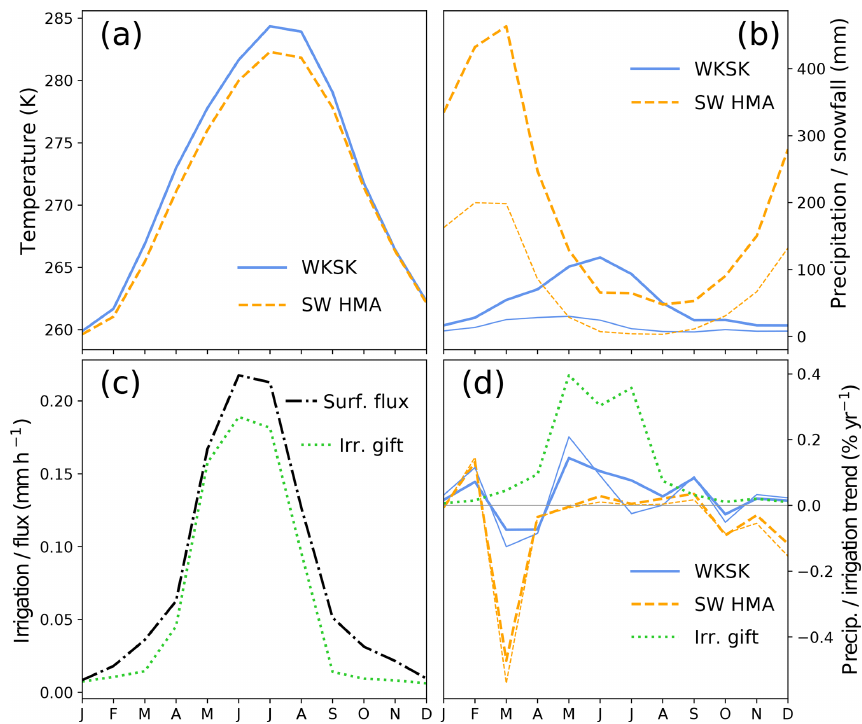
Figure 10. (a) Mean seasonal cycle of temperature and (b) precipitation (thick lines) and snowfall (thin lines) between 1980 and 2010 for the WKSK (blue lines) and south-western HMA (dashed orange lines), as shown in Fig. 14b, d. (c) Mean seasonal cycle of the irrigation gift (dotted green line) and surface moisture flux (dot-dashed black line) of the most heavily irrigated point in the Tarim. (d) Trends in precipitation (thick lines) and snowfall (thin lines) for the WKSK (blue lines) and south-western HMA (dashed orange lines) and the trend in irrigation from the most heavily irrigated point in the Tarim (dotted green line), all as percentages of the annual mean value.